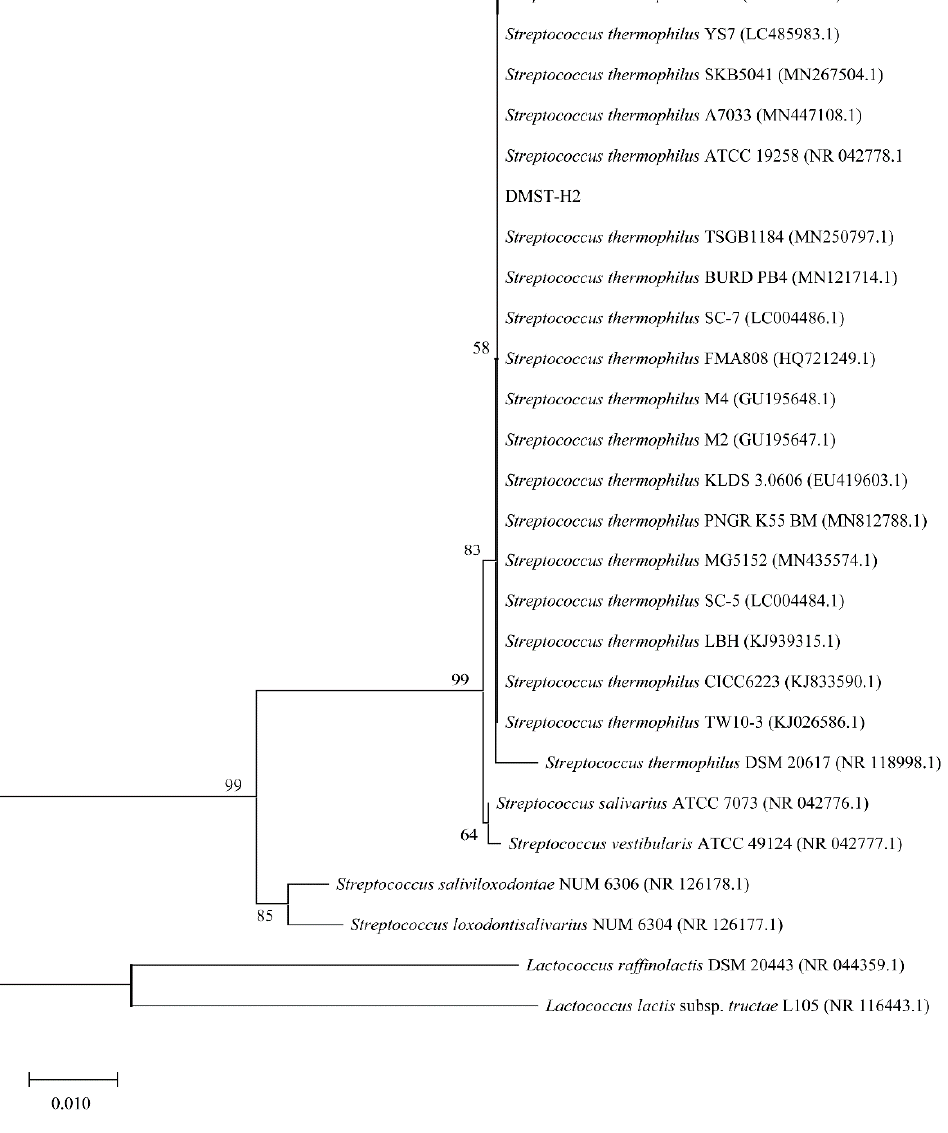
Figure 2. Phylogenetic tree of DMST-H2 16S rRNA gene.